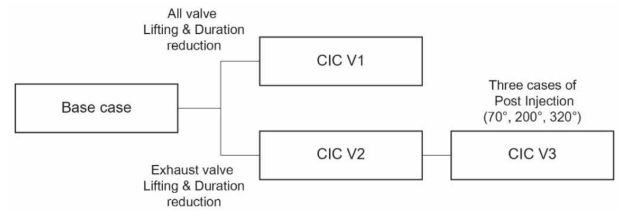
Figure 2. Schematic diagram of this numerical analysis process.